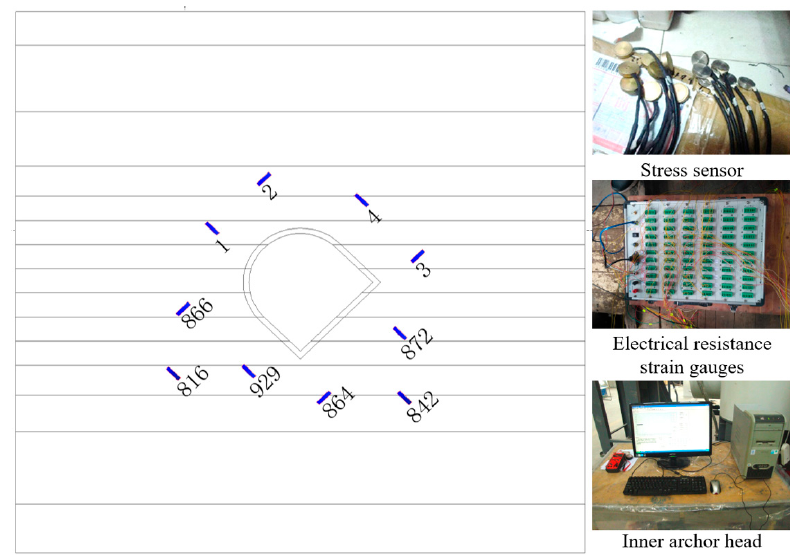
Figure 2. Stress-measuring equipment and its layout.